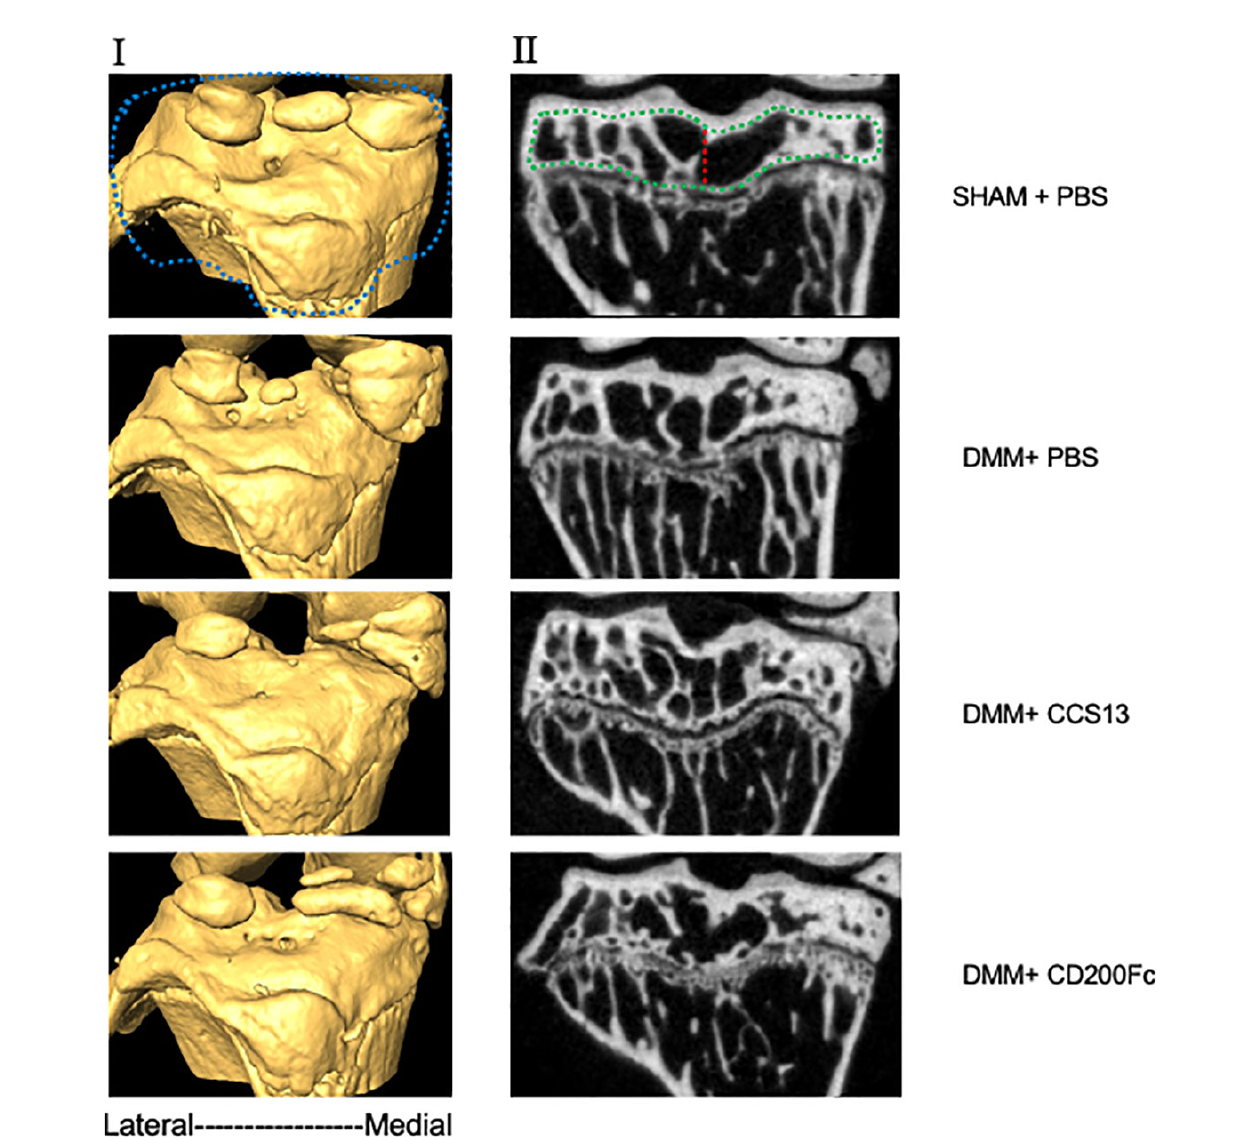
FIGURE 4 | MicroCT images of representative specimens (3D model in panel I and 2D coronal slices in panel II). Stereological analysis involved a series of cropping steps in order to isolate the region of interest. First, the epiphyseal region, demarcated by blue line, was crudely selected in the 3D reconstructed model. Next, the subchondral trabecular bone (green line) was segmented in 2D slices. Finally, the segmented slices were merged and divided into lateral and medial halves (red line) and analyzed